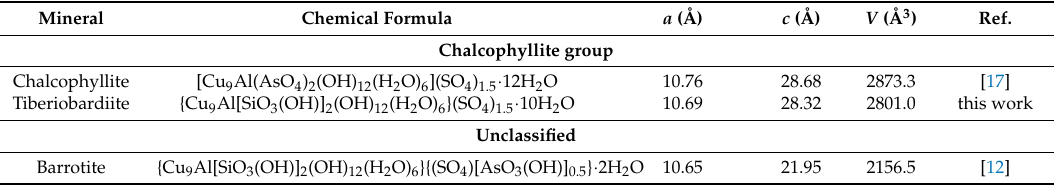
Table 8. Members of the chalcophyllite group and related